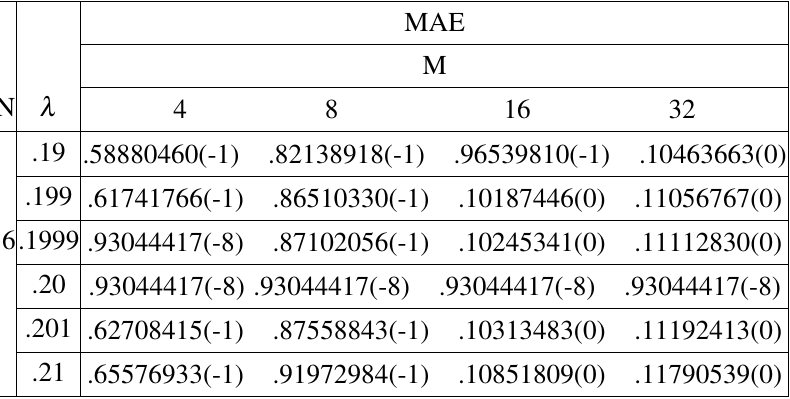
Table 3 Maximum absolute error (Problem 1).